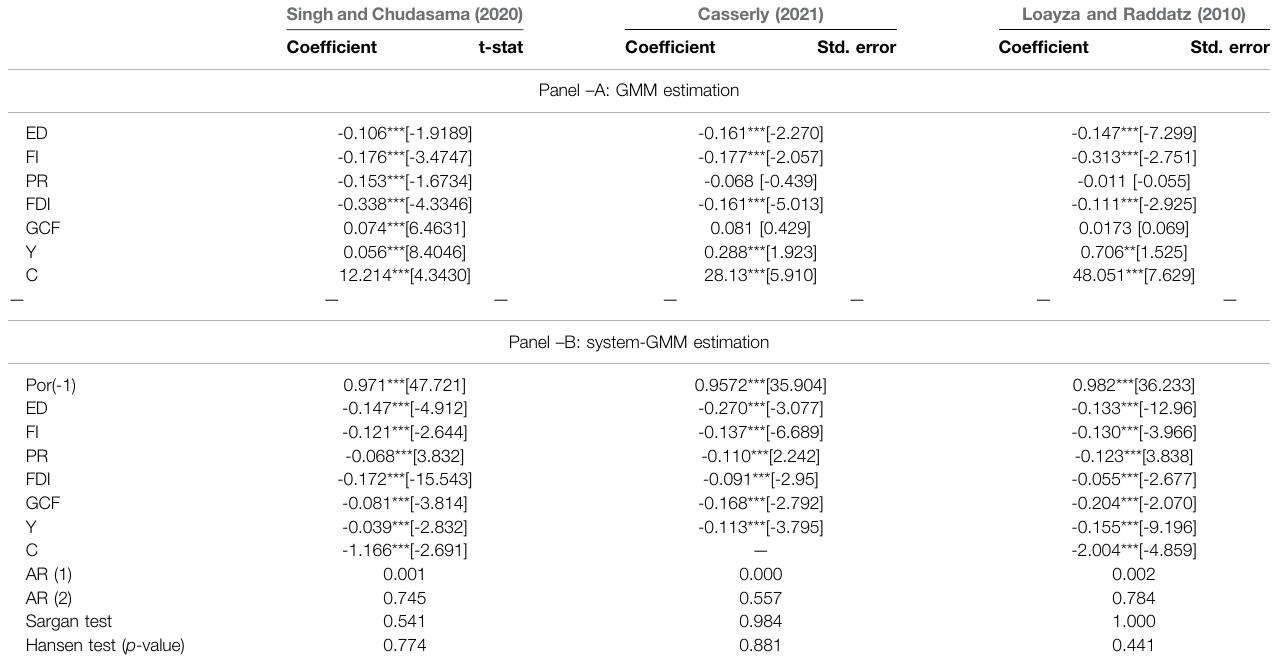
TABLE 10 | Results of GMM